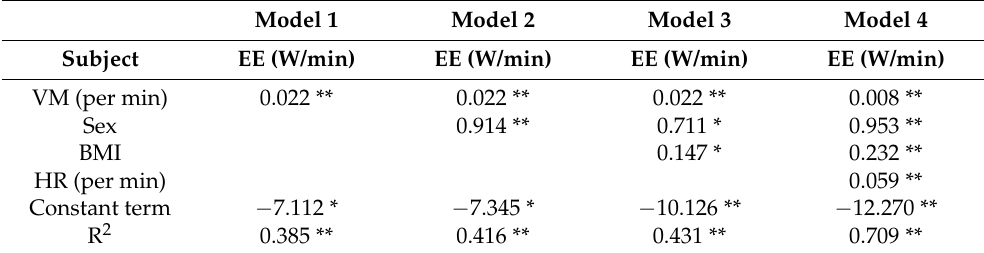
Table 5. Energy consumption model (based on